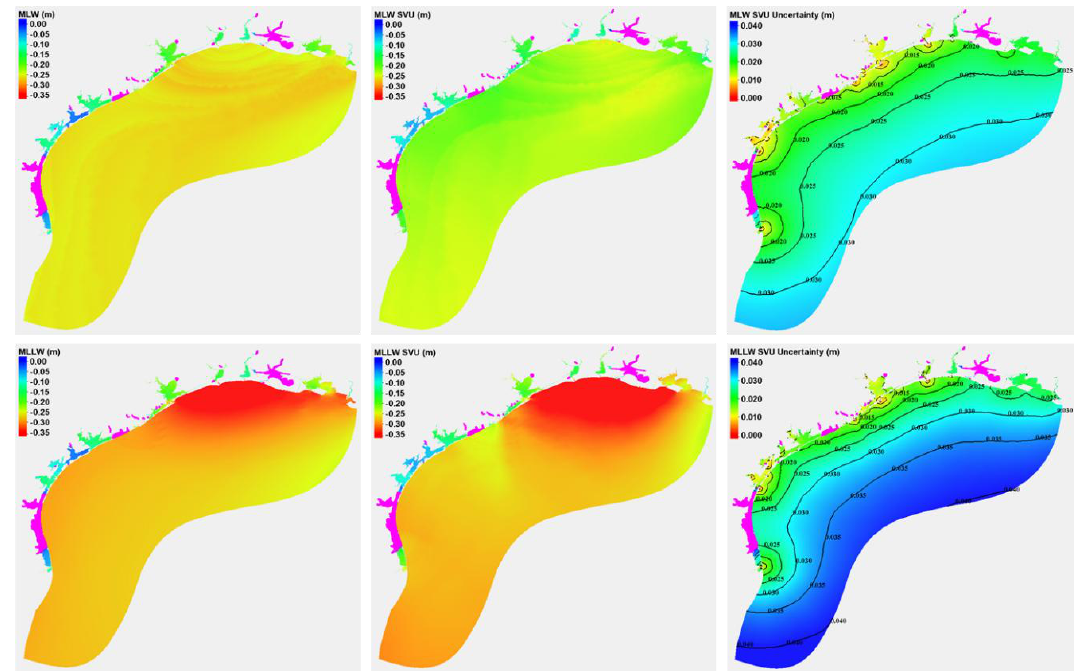
Figure 10. Modeled MLW ( upper row ) and MLLW ( lower row ) tidal datums. The first column shows ADCIRC modeled tidal datums; the second column shows the tidal datums after the SVU statistical interpolation; the third column shows the associated SVU spatially varying uncertainties. Model grid points in pink represent the modeled non-tidal grid points (modeled MHW-MLW < 0.09 m).